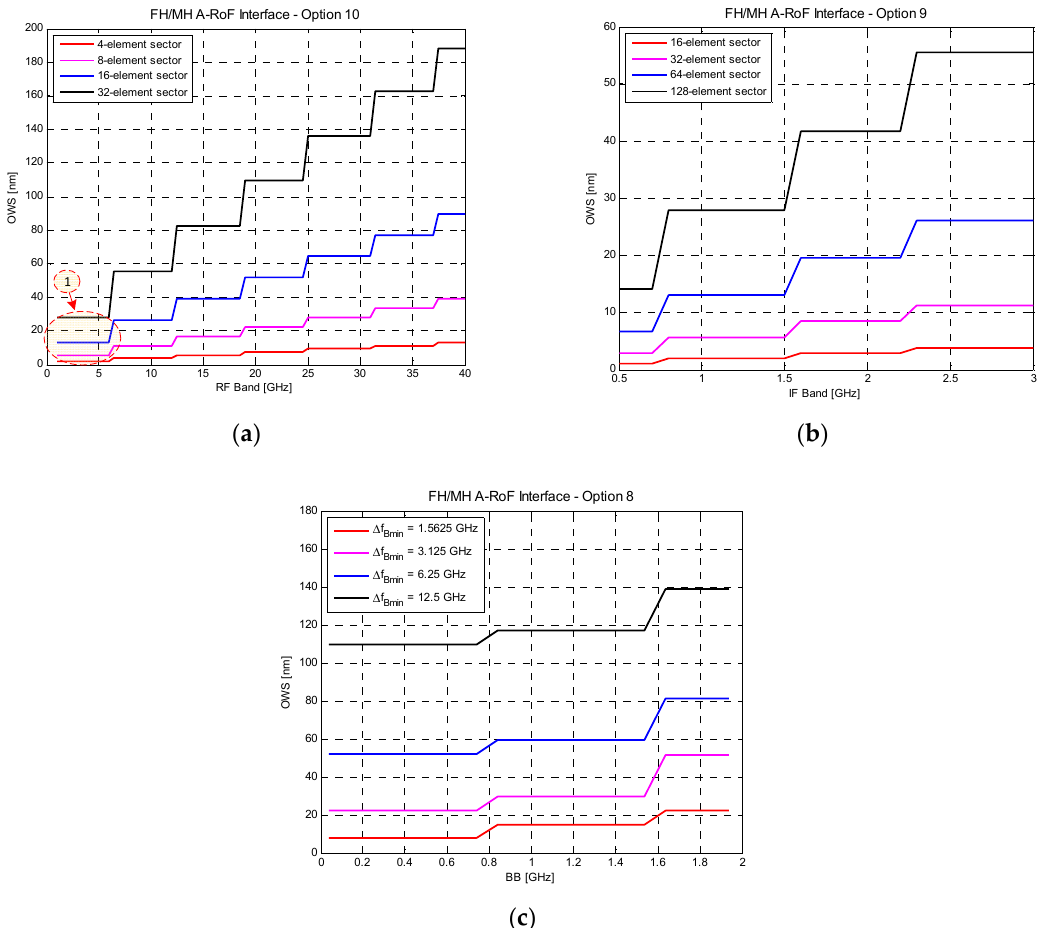
Figure 12. Calculation results of needs for optical resources in optical A-RoF fronthaul/midhaul path from gNB-CU/BBU/DU to 4-sector gNB-DU/RRH/AAU presented as Optical Wavelength Spectrum (OWS)—count-down from 1675 nm optical carrier (band U): ( a ) Option 10 (proposition—Figure 8)—analog transport of RF over optical DWDM link (min. Δ f = 12.5 GHz); ( b ) Option 9 (proposition—Figure 8)—analog transport of IF over optical DWDM/UDWDM link (min. Δ f = 1.5625 GHz); ( c ) analog transport of baseband over optical DWDM link (128 antennas per sector)—extension of Option 8 (proposition—Figure 8).